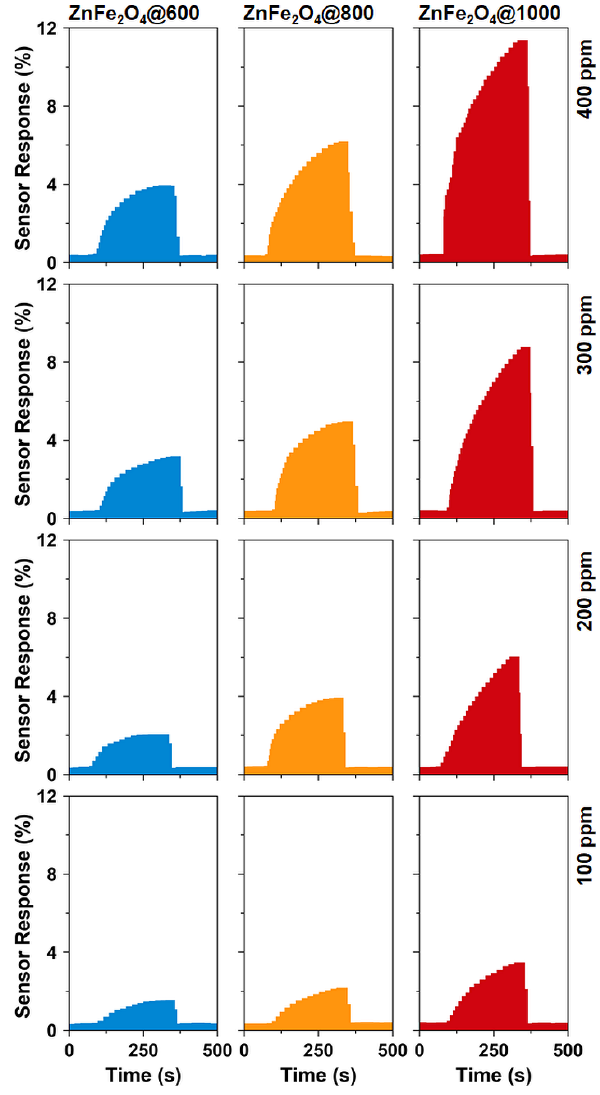
Figure 6. Time-dependent sensor response of the annealed ZnFe 2 O 4 nanoparticles toward 100–400 ppm NO 2 gas at 600 °C.